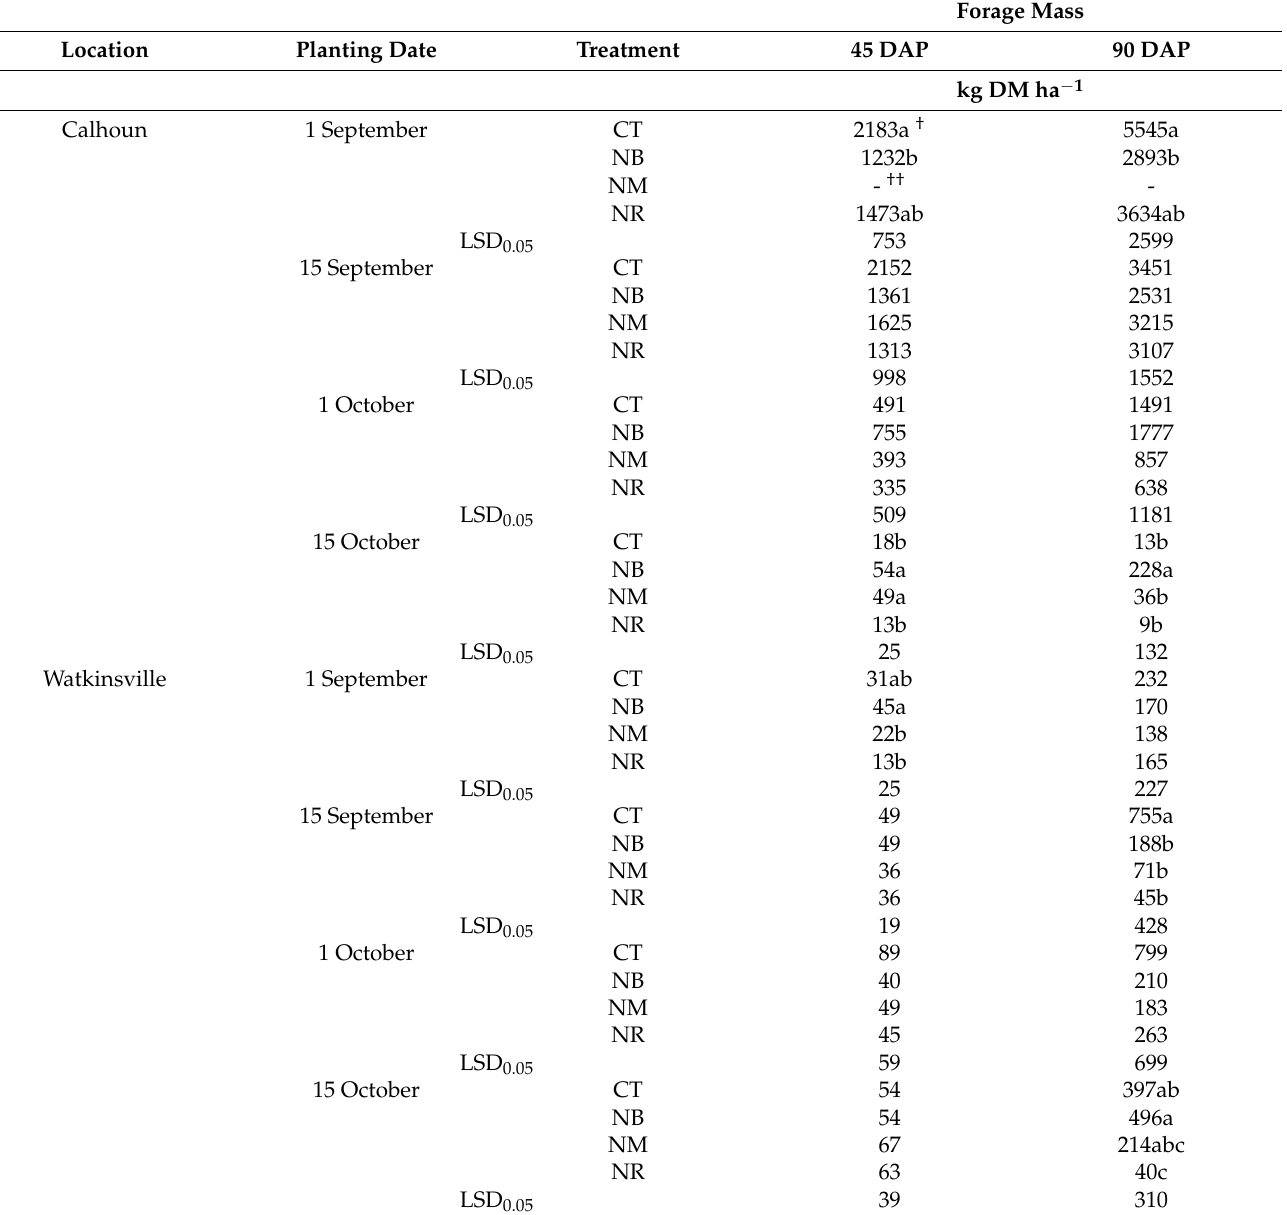
Table 1. Forage mass of canola at each land preparation method: conventional till (CT), no–till burn (NB), no–till mow (NM), and no-till with residue (NR) land preparation methods on four planting dates: 1 September, 15 September, 1 October, and 15 October at the Calhoun, GA and Watkinsville, GA locations for canola grown in